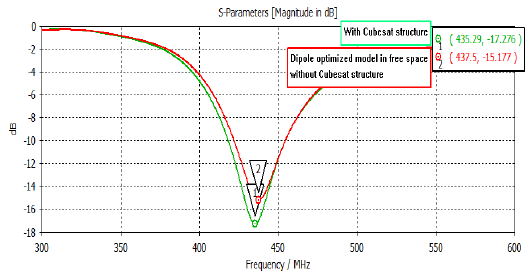
Figure 10. Masat-1 halfwave dipole antenna return loss before and after introducing the Cubesat metallic structure Tuning the antenna frequency required further shortening of the dipole length. We got excellent results given the following parameters: L = 3.148mm, Gap = 2 mm and Radius = 0.685mm - Fig. 11(a) and 11(b). Indeed, the value of return loss has been found as – 17.29 dB, VSWR = 1.3was achieved, and 36.4MHz of bandwidth is readily available. Also, as it is shown in Fig. 12(a) and 12(b), the directivity of